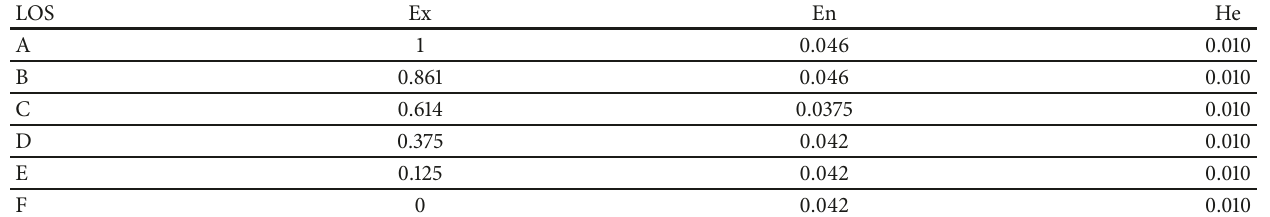
Table 9: In-vehicle evaluation index standard cloud.